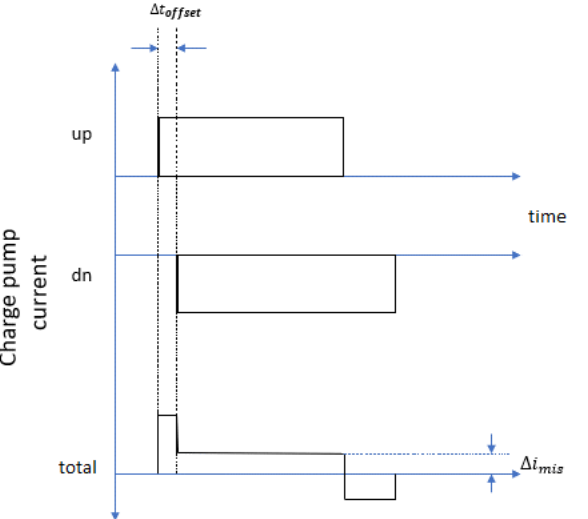
Figure 2. Impact of mismatches in charge-pump currents and pulse-arrival